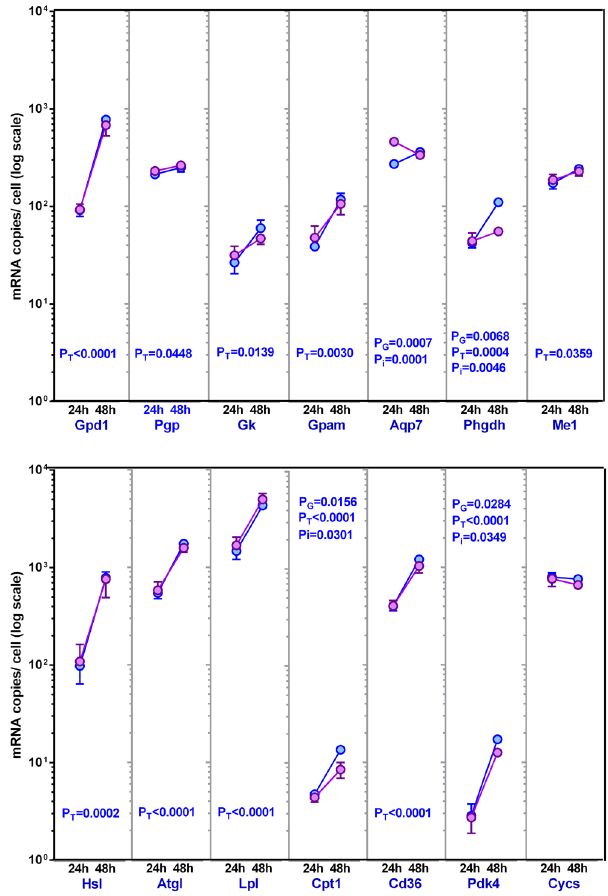
Figure 3. Gene expression of proteins related to glycerol metabolism in adipocytes incubated under varying glucose concentration for up to 48 h. The data are presented as number of copies of the corresponding mRNA per cell, and are mean ± sem of data from four rats. The data were obtained from the “parallel” incubations (i.e. no label). The results are shown in a log scale to facilitate comparisons of copies per cell between genes and groups. Blue dots and lines: initial 7 mM glucose, mauve dots and lines: 14 mM glucose. The statistical significance data and conventions are the same as in Figure 1. The correspondence between gene names and those of the proteins they code are given in the text and can be seen in Table